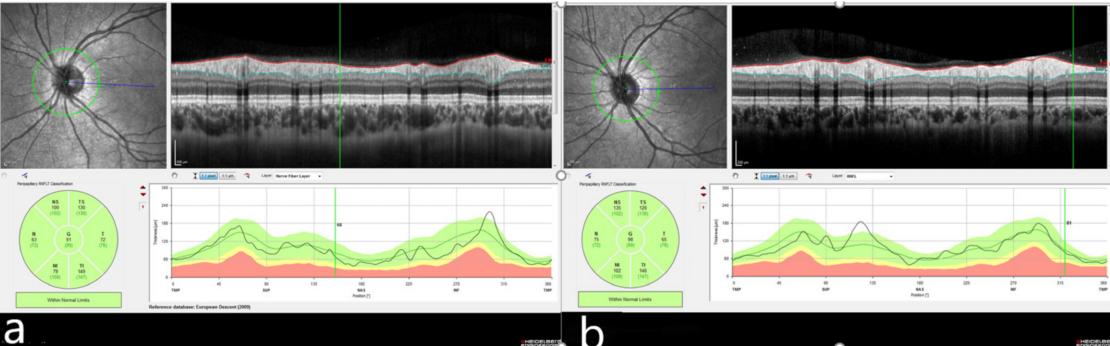
Figure 3. ( a ) Retinal nerve fiber layer thickness measurements obtained by spectral-domain optical coherence tomography in a child with immunoglobulin A vasculitis. ( b ) Retinal nerve fiber layer thickness in a child from the control group. Images were obtained by averaging multiple B-scans from the same position in both